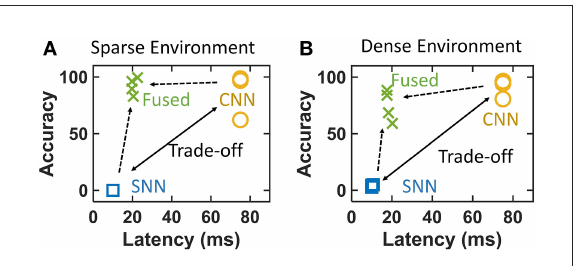
FIGURE7 Mitigation of accuracy vs. latency trade-off in both (A) sparse and (B) dense environments. The dense environment provides lower relative fused accuracy compared to the sparse environment because of higher noise in SNN outputs.